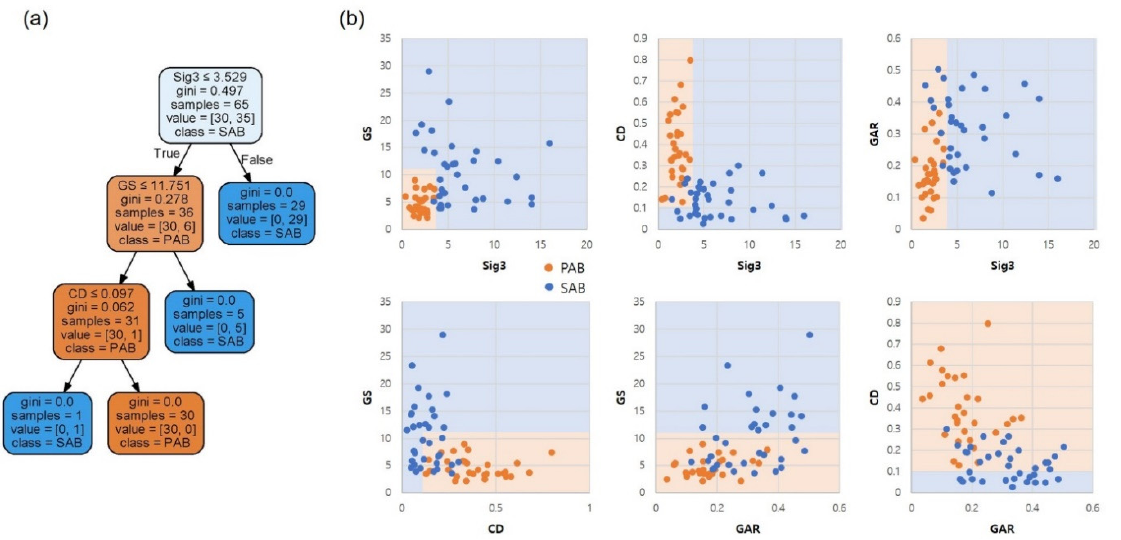
Figure 9. ( a ) Decision tree plot and ( b ) decision surfaces on the pairs of discriminant factors.